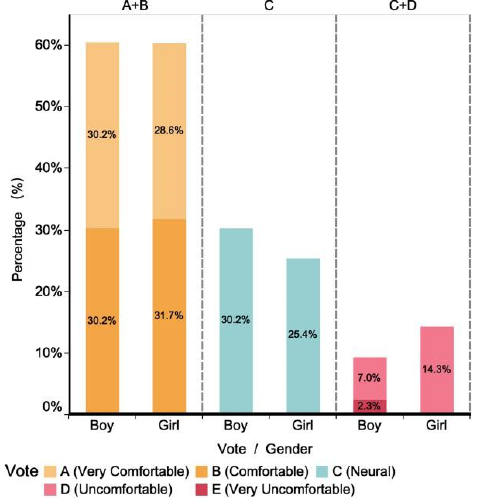
Figure 10. Votes regarding pupils’ comfort level with opening windows. 222